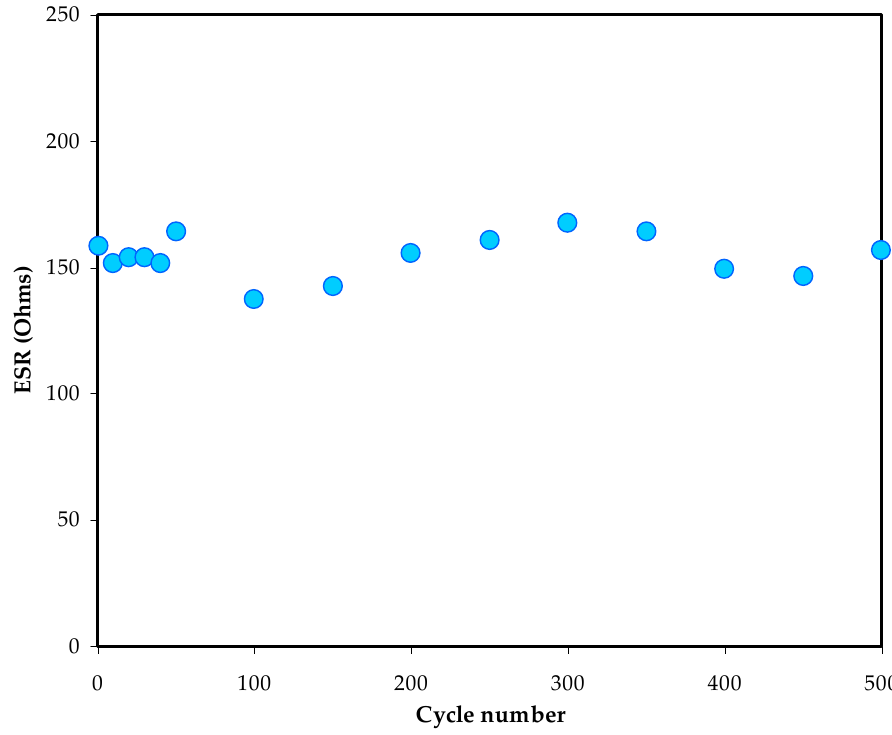
Figure 17. ESR of the EDLC for 500 cycles.